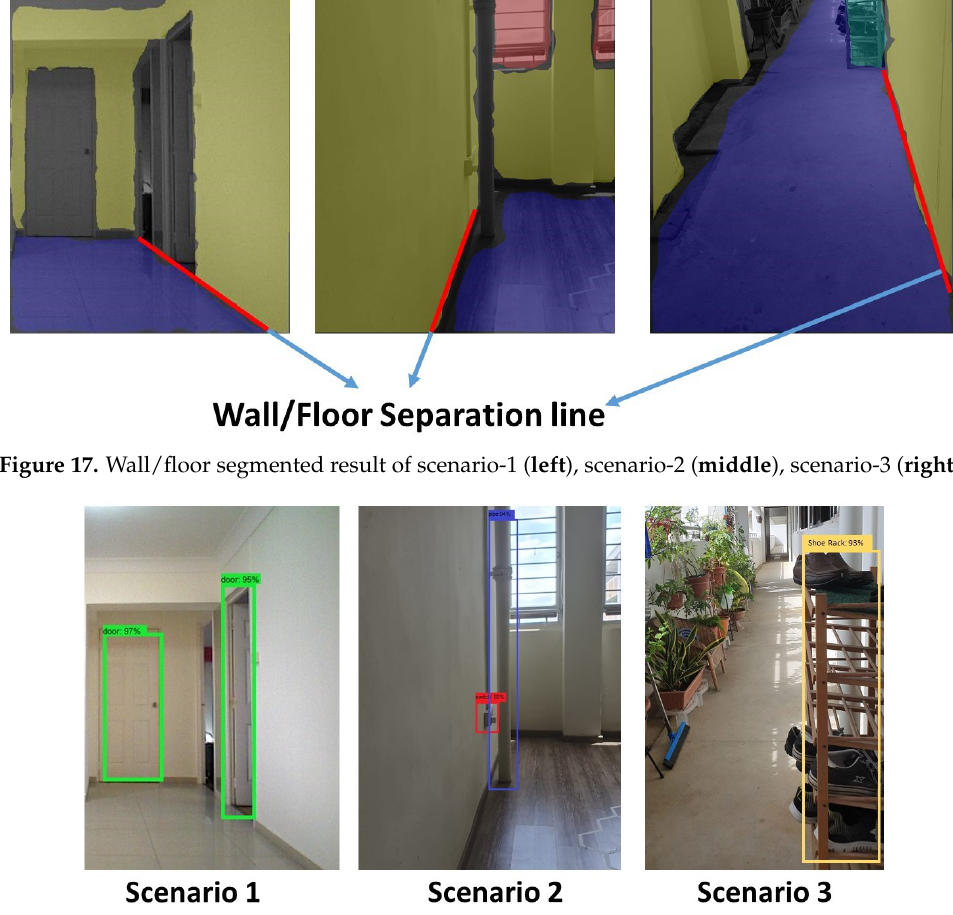
Figure 18. Object detection result during trials in scenario-1 ( left ), scenario-2 ( middle ), scenario-3 ( right